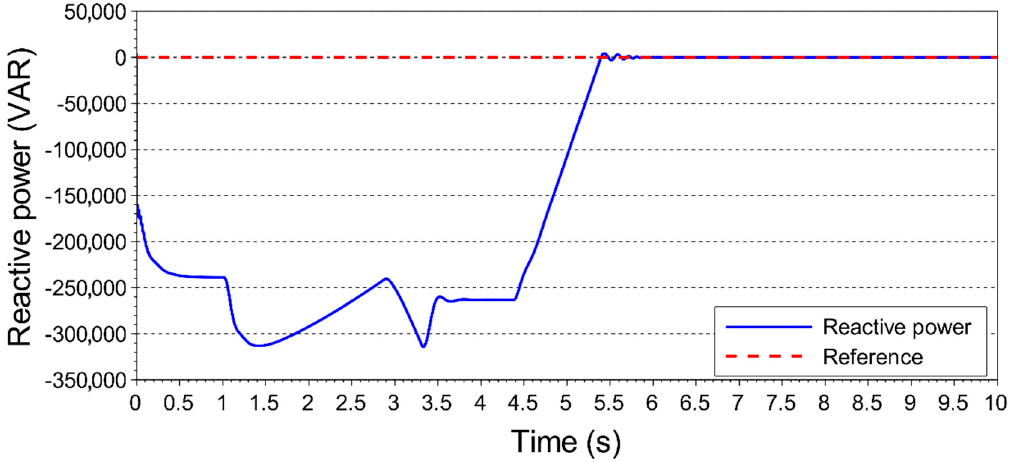
Figure 13. Reactive power at a wrong operation point and after magnetizing inductance correction.